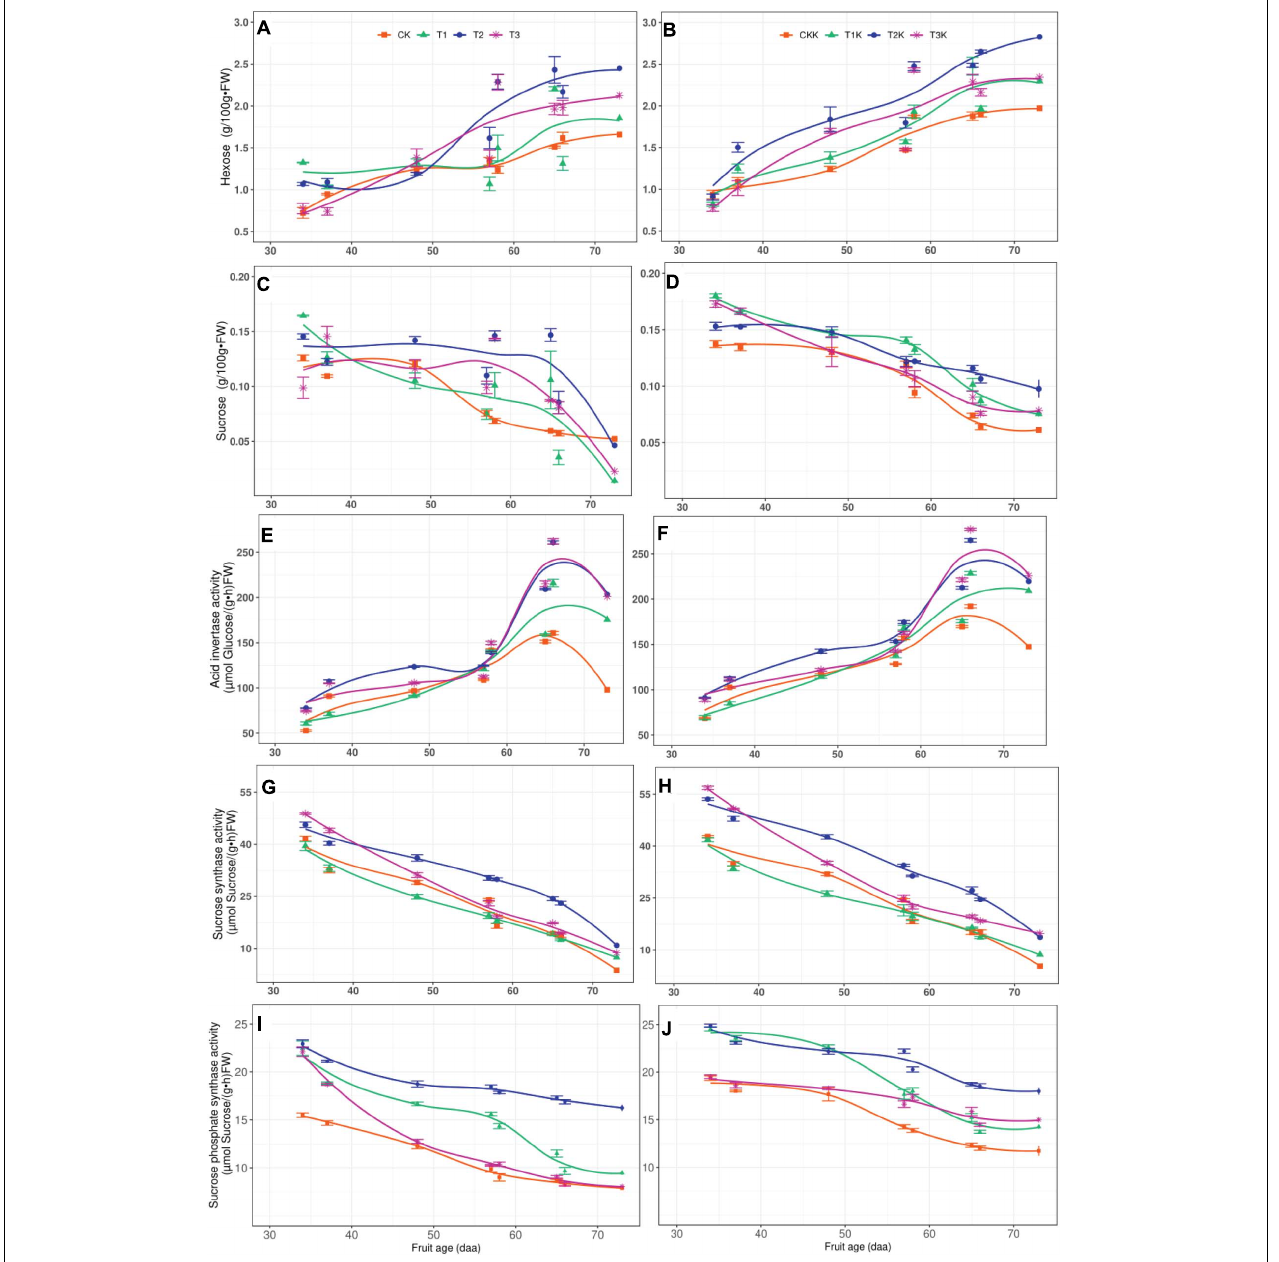
FIGURE 4 | Related sugars and sucrose metabolic enzymes activity in fruit. Measured hexose (points), sucrose (points), acid invertase (points), sucrose synthase (point), sucrose phosphate synthase (point) and their corresponding fitted curves (lines) for the different water and potassium treatments as a function of days after anthesis (DAA). (A) Variation of Hexose with fruit age for different water treatments. (B) Variation of Hexose with fruit age for different water and potassium treatments. (C) Variation of Sucrose with fruit age for different water treatments. (D) Variation of Sucrose with fruit age for different water and potassium treatments. (E) Variation of AI activity with fruit age for different water treatments. (F) Variation of AI activity with fruit age for different water and potassium treatments. (G) Variation of SuSy activity with fruit age for different water treatments. (H) Variation of SuSy activity with fruit age for different water and potassium treatments. (I) Variation of SPS activity with fruit age for different water treatments. (J) Variation of SPS activity with fruit age for different water and potassium